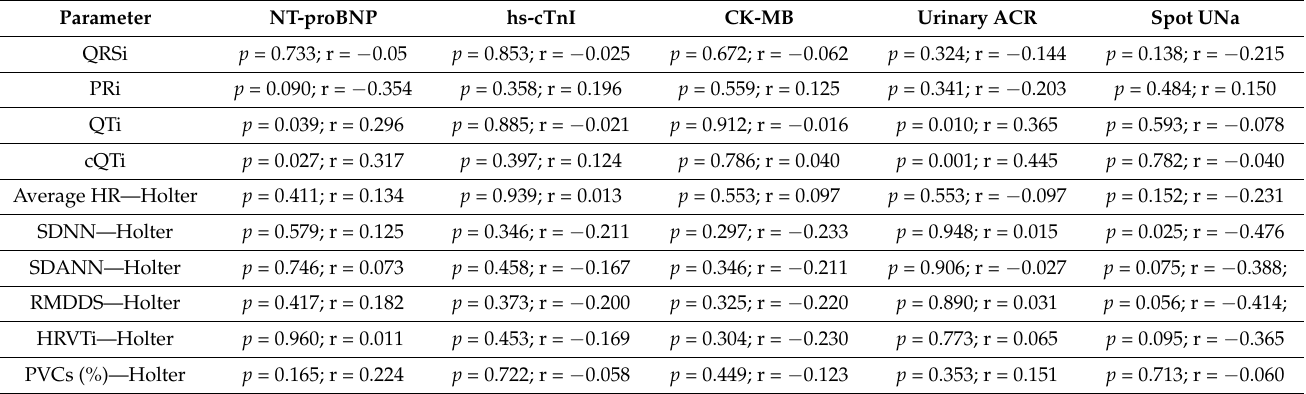
Table 11. Correlations of biomarkers with ECG and Holter parameters in patients with AHF.